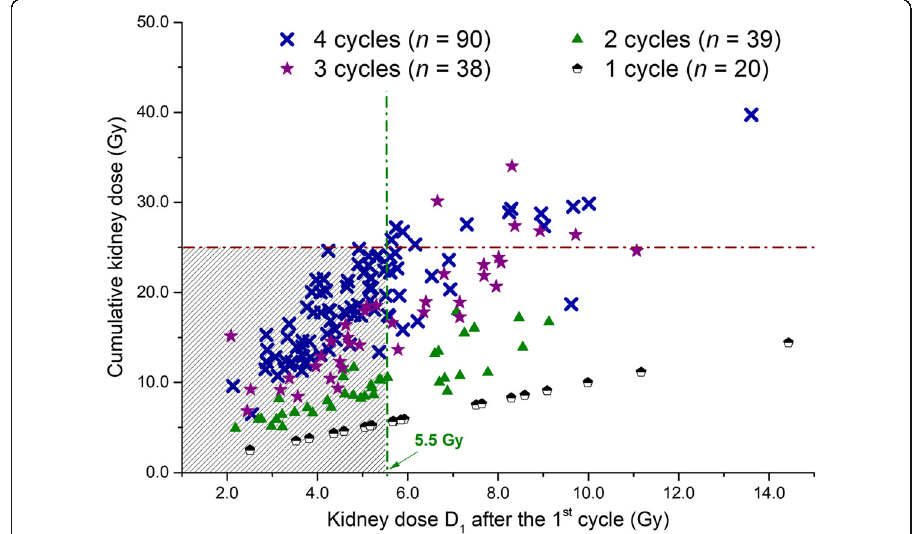
Fig. 2 Cumulative kidney absorbed dose versus kidney absorbed dose after the first cycle. Legend: Relationship between the cumulative absorbed dose to kidneys and the absorbed dose after the first cycle. Horizontal dashed line: 25 Gy threshold. Vertical dashed line: threshold under which all patients completed 4 cycles with D T under 25